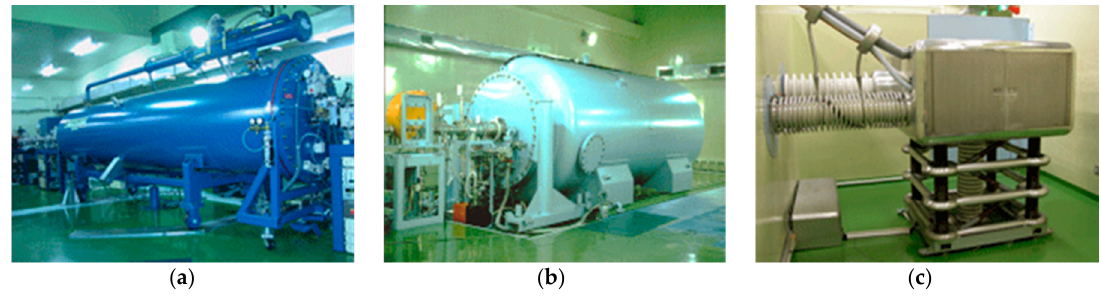
Figure 13. Three electrostatic accelerators at TIARA. ( a ) 3 MV tandem accelerator; ( b ) 3 MV single- ended accelerator; ( c ) 400 kV Ion implanter. accelerator; ( c ) 400 kV Ion implanter.